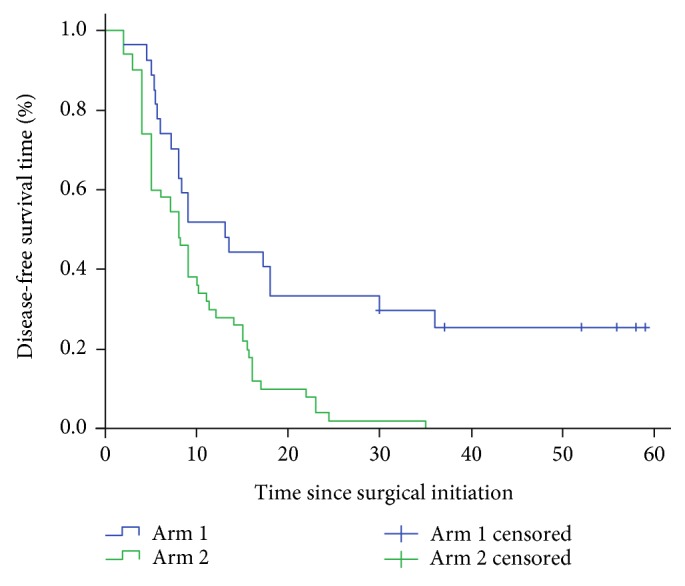
Disease-free survival time of Arm 1 versus Arm 2 was calculated in 27 patients in Arm 1 compared with 50 patients in Arm 2.